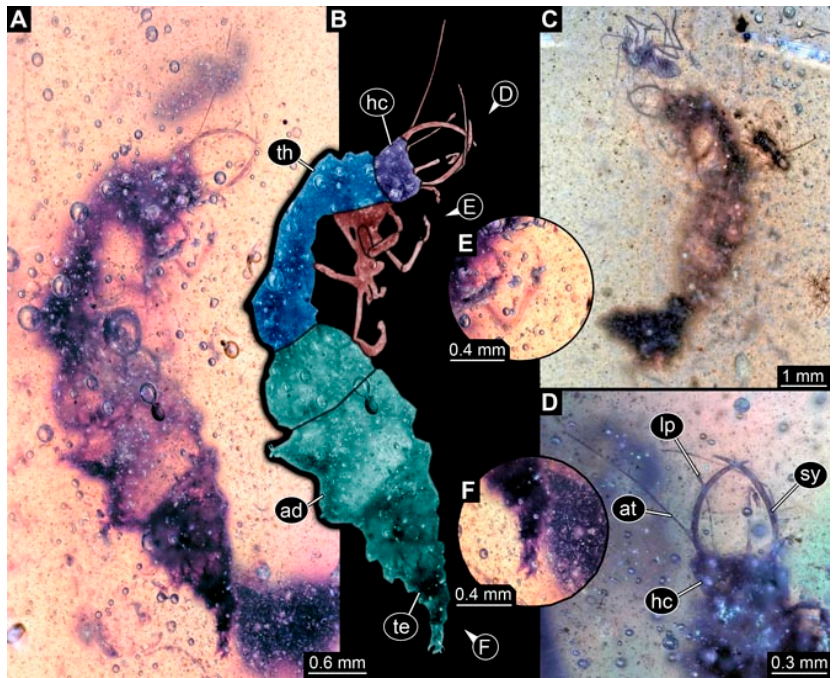
Figure 8. Specimen 4826 (BUB 3393); Myanmar amber. ( A ) Dorsal view. ( B ) Dorsal view, colour-marked. ( C ) Ventral view. ( D ) Close-up of head capsule in dorsal view. ( E ) Close-up of trunk appendage. ( F ) Close-up of trunk end in dorsal view. Abbreviations: ad = abdomen; at = antenna; hc = head capsule; lp = labial palp; sy = stylet; te = trunk end; th = thorax.